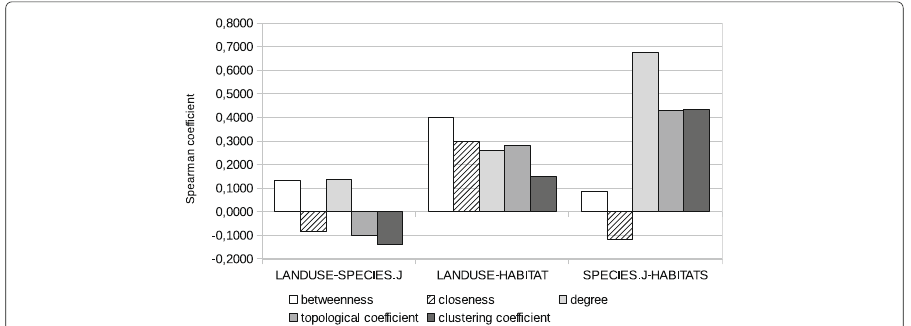
Fig. 4 Histogram representation of Spearman correlation of various complex network indices, between pairs of similarity-based graphs. Species-set graphs built using Jaccard coefficients, land-use and habitats graphs built using cosine similarity of